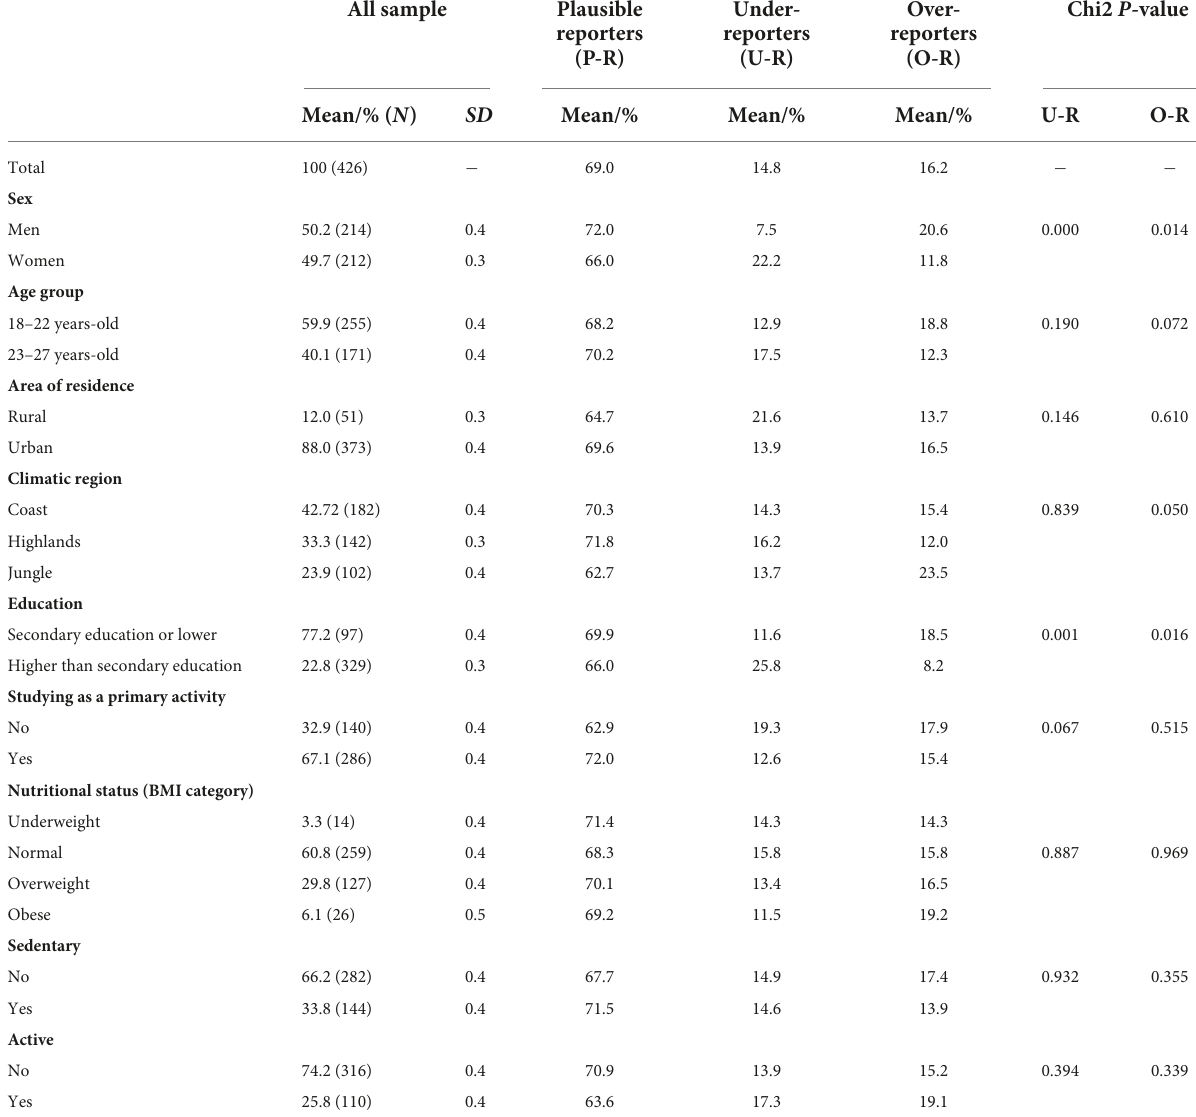
TABLE 1 Characteristics of the participants stratified by misreporting status. All